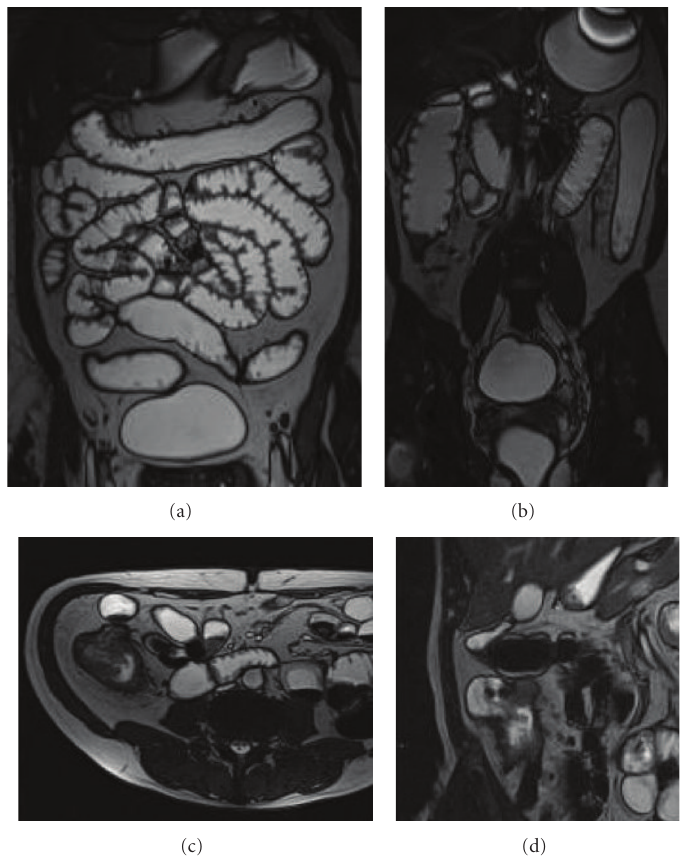
Figure 8: MR-E. Crohn’s disease: colon involvement (a), (b) coronal TRUFI T2 showing (c) axial TRUFI T2; (d) coronal TRUFI T2.